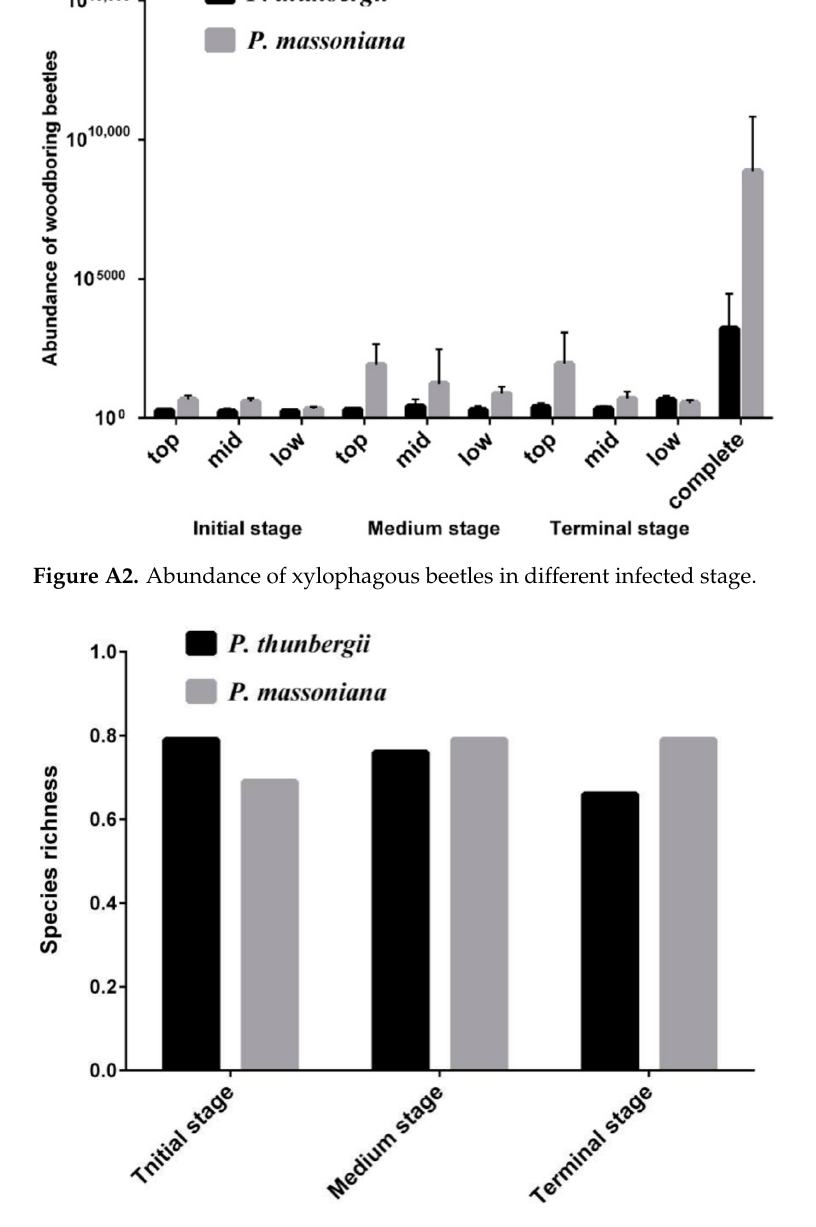
Figure A3. Species richness of xylophagous beetles in different infected stages. Table A1. The average height, diameter at breast height (DBH), and annual ring of the sample pine trees in the infected P. thunbergii and P. massoniana